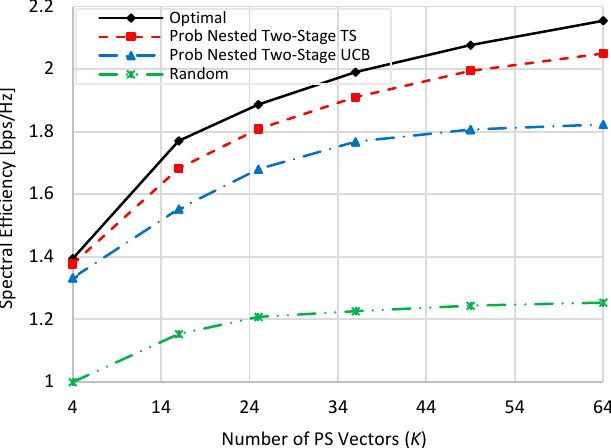
Figure 3. Spectral efficiency against the used number of PS vectors when M = N = K at 80% blockage.